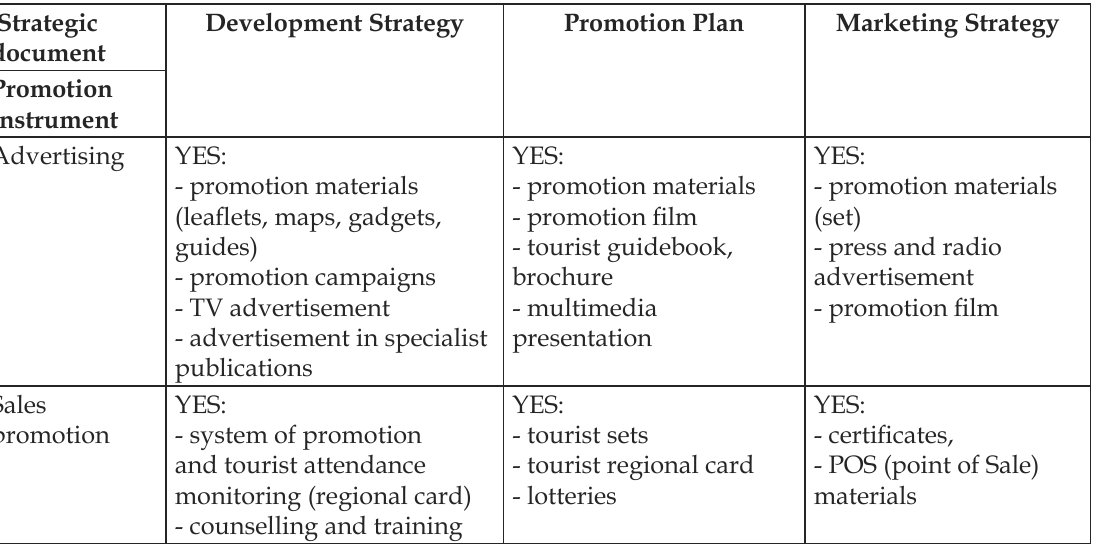
Tab. 4. The promotion action of ‘the Barycz Valley’ according to strategic